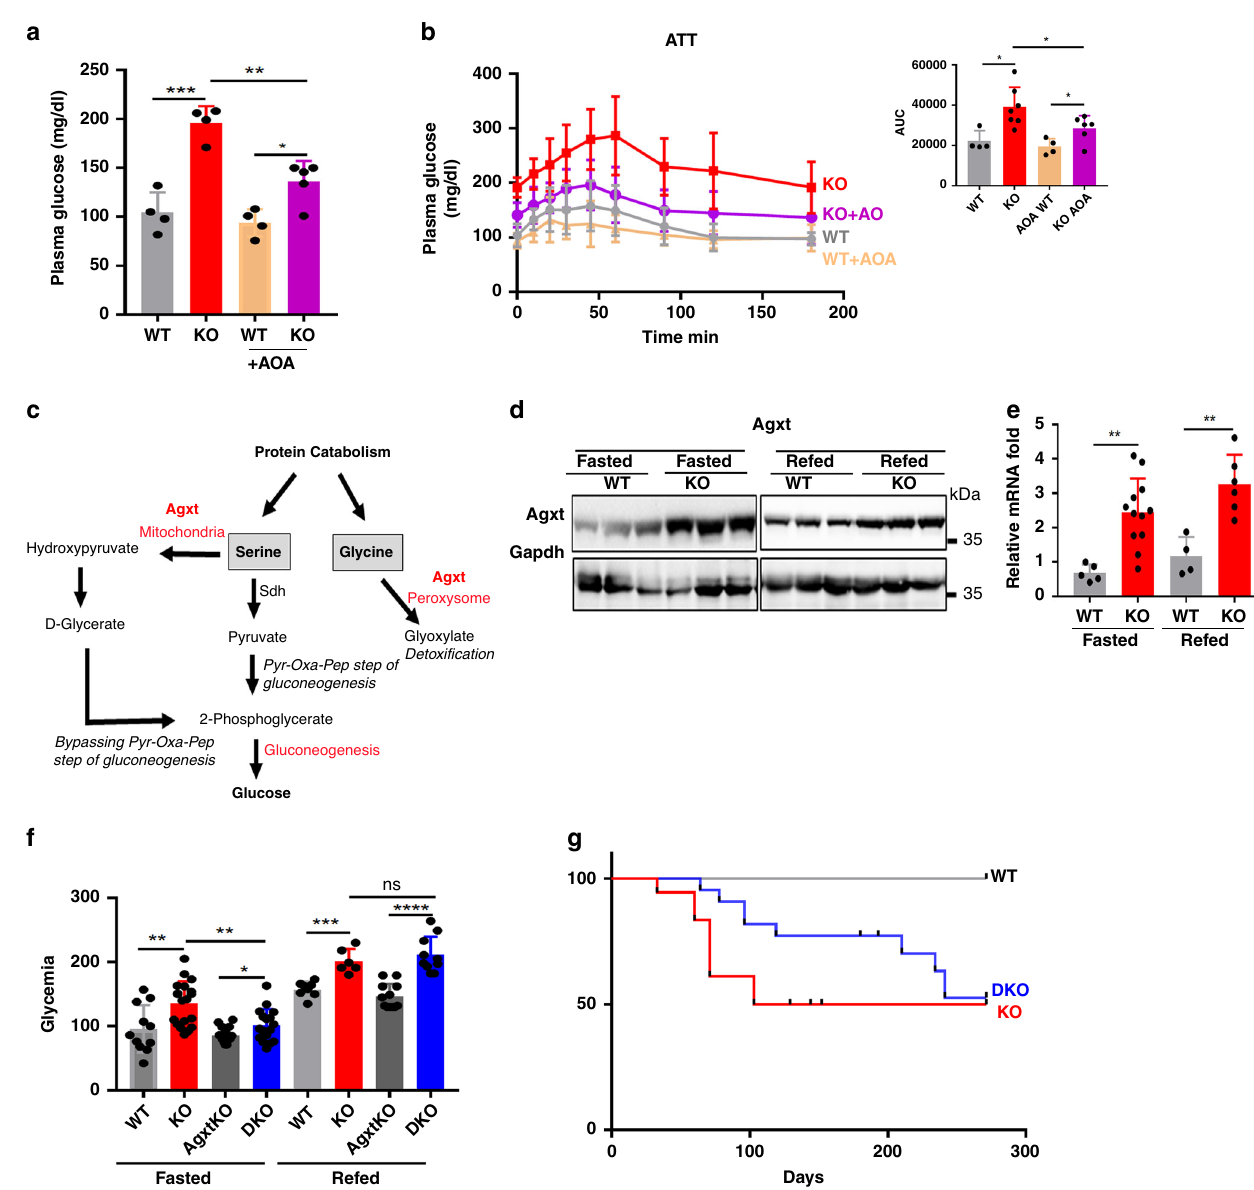
Fig. 6 Aminotransferases including Agxt are crucial effectors of the suppressor function of Lkb1 in amino acid-driven gluconeogenesis. a , b Pharmacological inhibition of aminotransferase, in vivo, by AOA. Lkb1KO livad (KO) and WT mice were left untreated ( − ) or were treated with AOA (10 mg/kg) 2 h before the determination of fasting blood glucose levels ( a ) or the alanine tolerance test ( b ). The area under the curve (AUC) of glucose level in the ATT is shown. AOA-treated animals, KO: n = 5, WT: n = 6. Animals not treated with AOA, KO: n = 5, WT: n = 4. Mice were fasted for 22 h before treatment with AOA or were left untreated for the same time period. c Scheme of the dual function of Agxt. d , e Agxt protein and mRNA levels in Lkb1KO livad (KO) mice. d immunoblot of Agxt in fasted and refed mutant (KO, n = 3) and control (WT, n = 3) mice. Representative blot of two independent experiments. e Agxt gene expression levels, as assessed by RT-qPCR in fasted (KO: n = 10, WT: n = 6) and refed (KO: n = 7, WT: n = 5) mice. f , g Phenotypes of mice lacking both Lkb1 and Agxt in the hepatocytes (DKO), as compared with mice with a single de fi ciency of Lkb1 in hepatocytes (Lkb1KO livad , KO) and controls (WT and AgxtKO). e Glycemia in fasting (WT: n = 11, KO: n = 19, DKO: n = 17, AgxtKO: n = 18) and refed (WT: n = 8, KO: n = 6, DKO: n = 10, AgxtKO: n = 12) mice. f Kaplan – Meier survival curves for Lkb1KO livad mice ( n = 18), mice lacking both Lkb1 and Agxt (DKO n = 23) and controls (WT, n = 10). All graphical data are means± SD. P values were determined by unpaired two-tailed t -test. ns: not signi fi cant. * p ≤ 0.05; ** p ≤